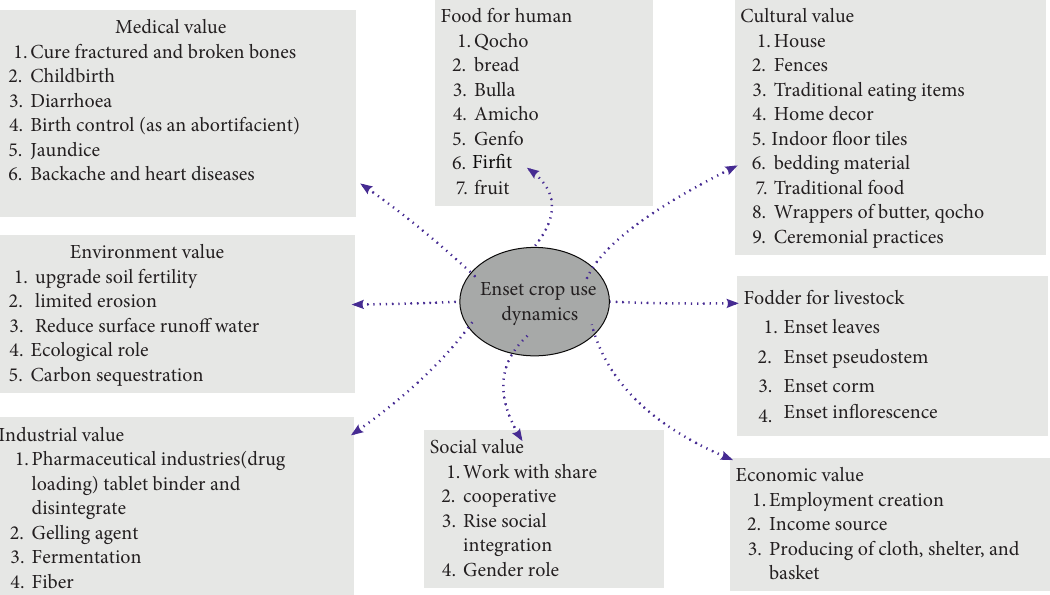
Figure 4: Use dynamics of Enset crop. Source: authors own elaboration.